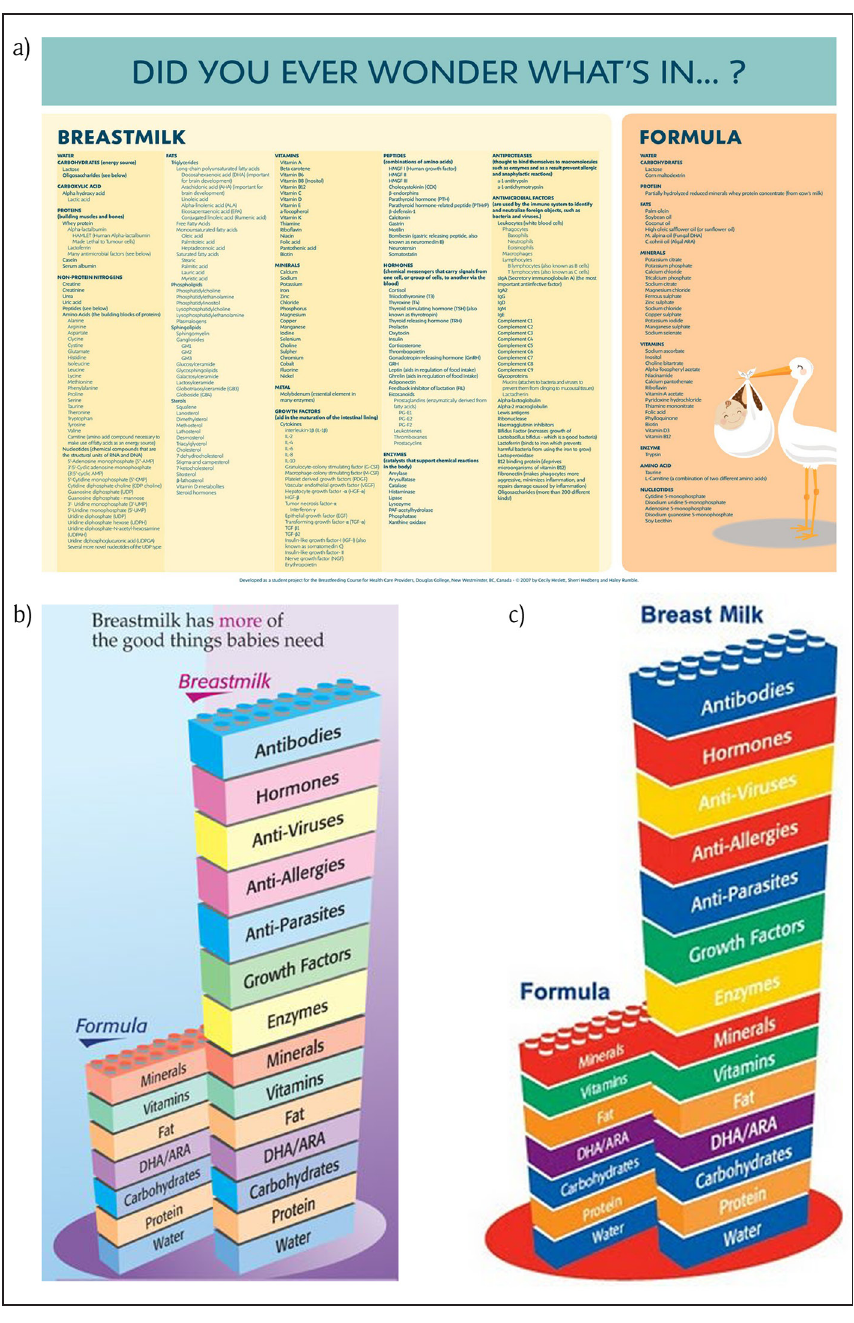
Figure 1: Breastmilk and formula